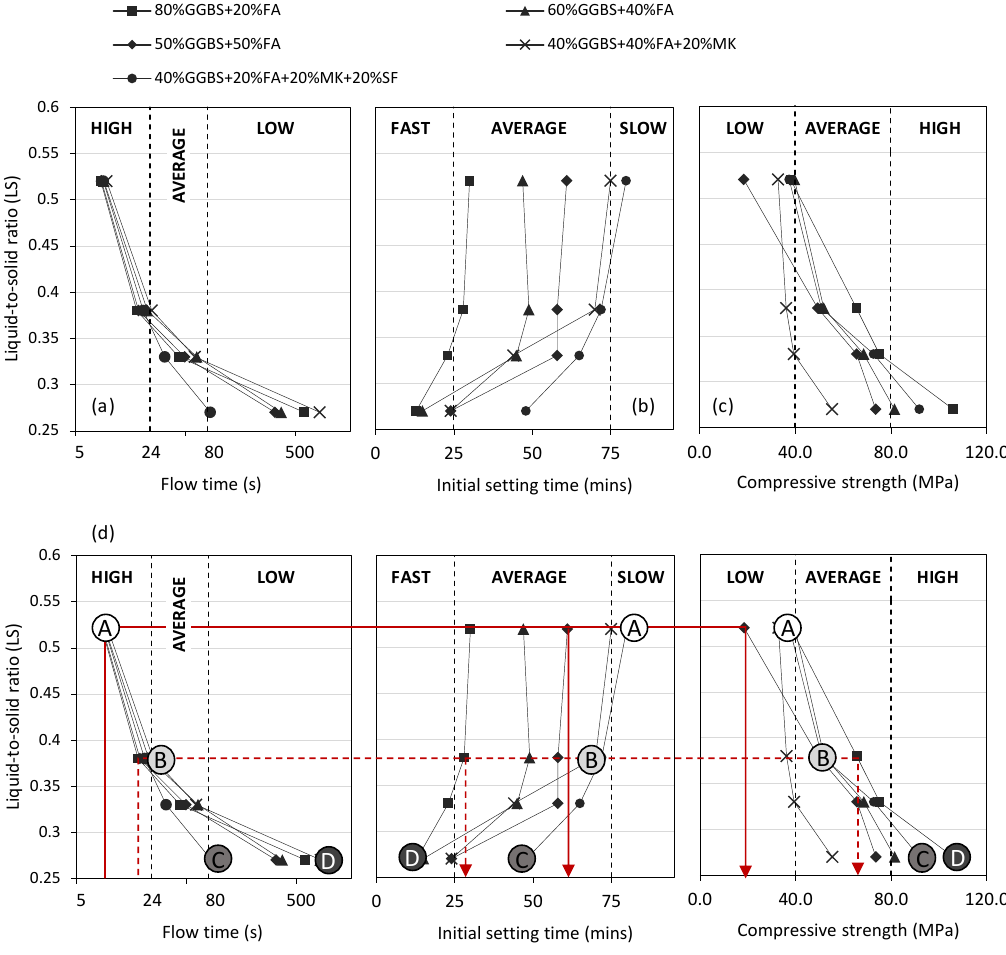
Figure 2. Performance of 20 geopolymer grout mixtures in terms of: ( a ) flow time; ( b ) initial setting time; and ( c ) 28-day compressive strength; ( d ) summary of selected grout mixes (Mix A, B, C, and D) for subsequent SFC characterisation phase.